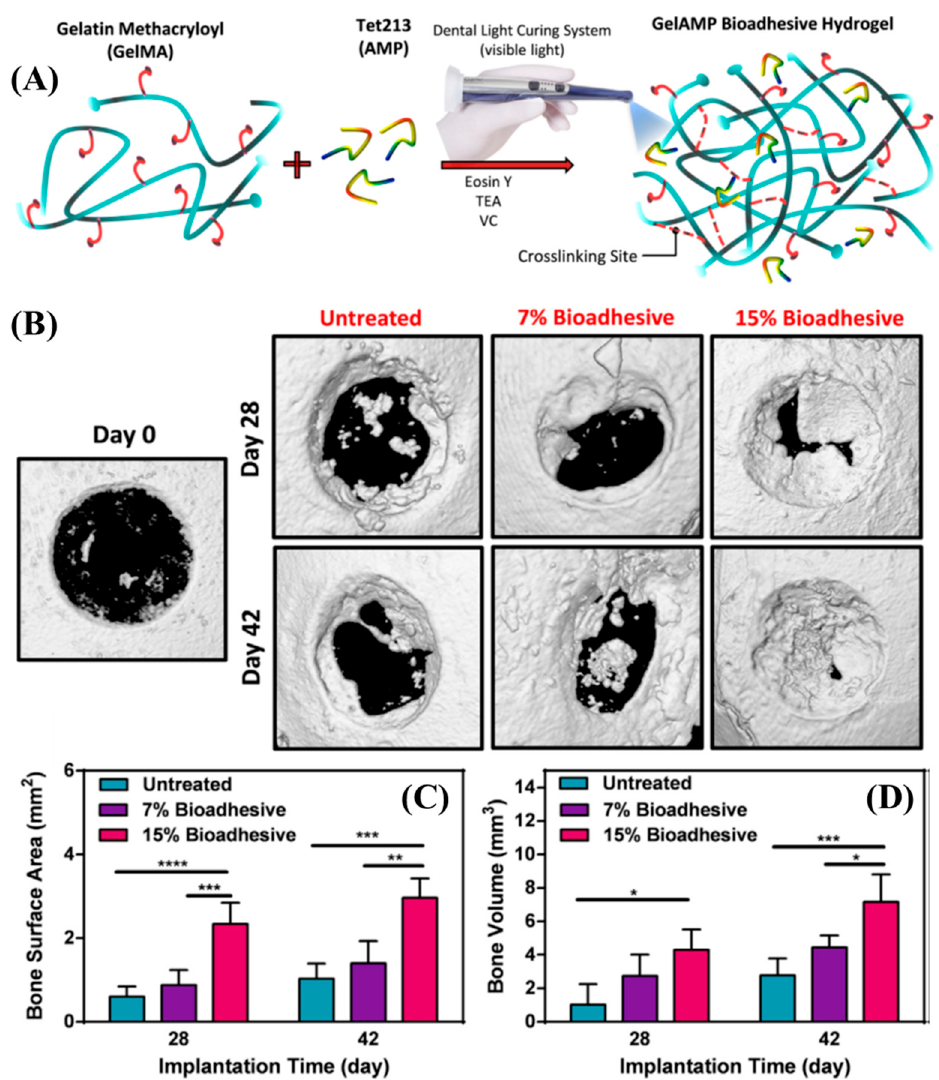
Figure 2. ( A ) Schematic representation of the modification, synthesis, and gelation of GelMA. ( B ) Representative micro-CT images for untreated defects and defects treated with 7 % and 15 % GelMA on Days 28 and 42 post-implantation. ( C , D ) Quantitative analysis of bone surface area ( C ) and bone volume ( D ) [46]. Copyright 2019, reproduced with permission from Elsevier Inc.